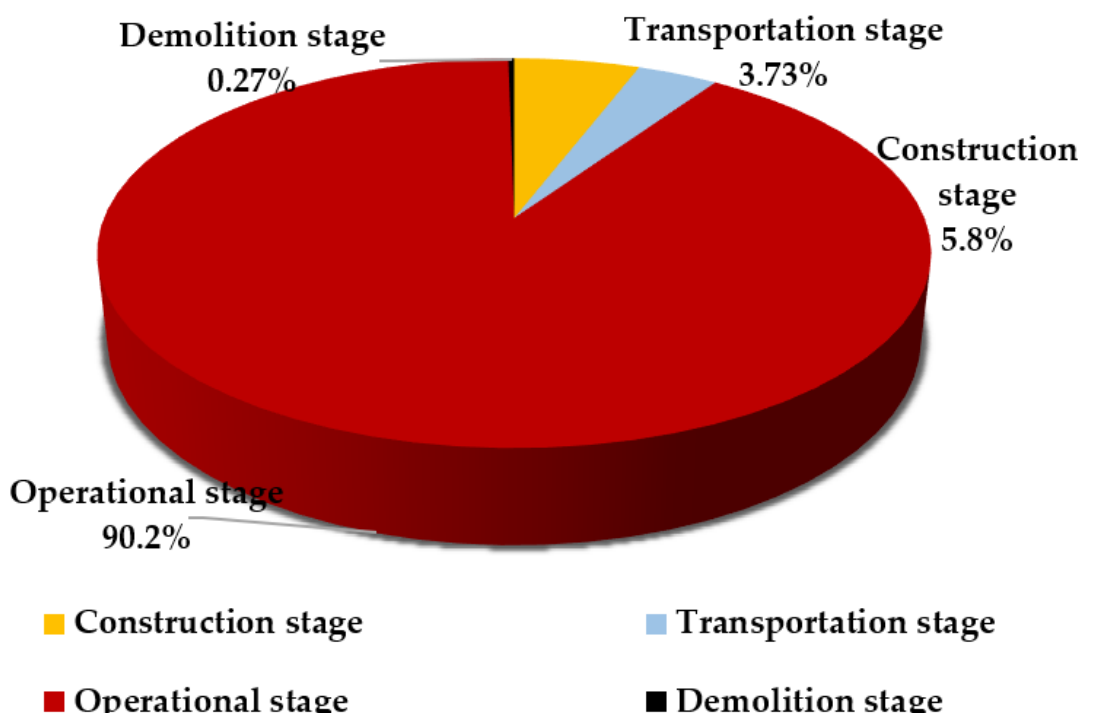
Figure 6. Percentage contribution of life cycle stages in GaBi database. Being a RCC structure, cement contributes about 66.6%, concrete masonry blocks about 9.4%, ceramic tiles and bricks contribute about 8.1%, and 15.7% of total carbon emissions of construction stage accounts for about 98.65 tCO 2 e in ICE database. In ecoinvent database from cradle to gate impacts, most contributing material is cement about 89 tCO 2 e, around 52.5%, concrete blocks around 4.3%, bricks 39.4% and ceramic tiles 3.8%. Similarly, in GaBi database, cement contributes around 64 tCO 2 e about 69.3%, concrete blocks 8.4%, bricks 15.9% and ceramic tiles 6.4%, respectively. In addition, it is evident from Figure 7 that cement is the highest contributor of carbon emissions in all databases.